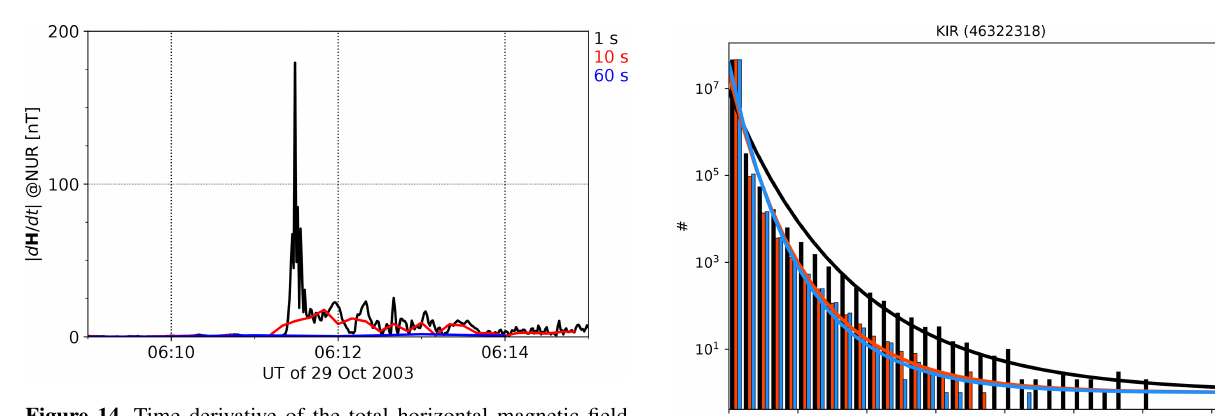
Figure 14. Time derivative of the total horizontal magnetic field ( | d H / d t | ) derived from 1, 10s, and 1min data at NUR on 29 Octo- ber 2003 between 06:09:00 and 06:15:00UT.